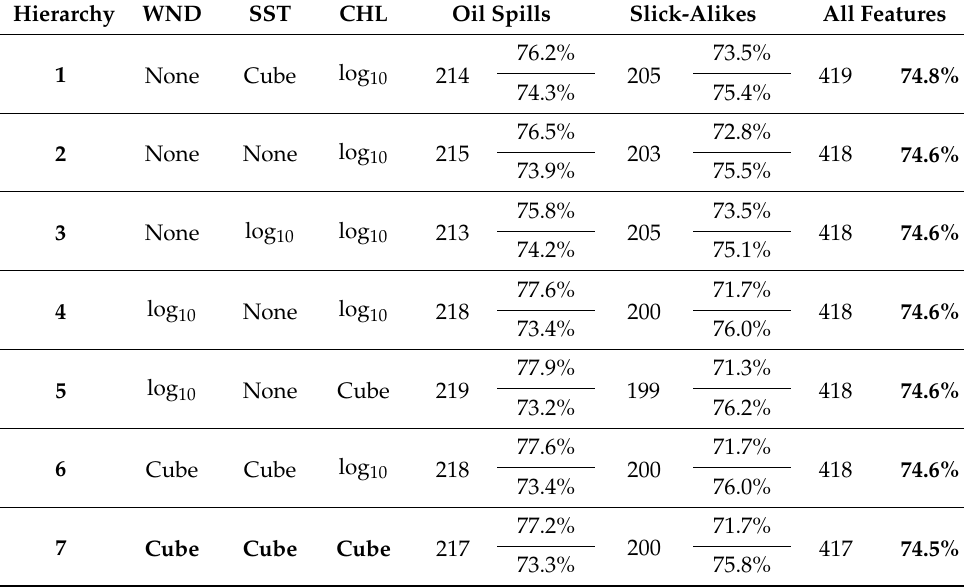
Table 6. Classification accuracy hierarchy of the 27 algorithms using three variables subjected to different data transformations in the same analysis—Meteorological-Oceanographic data (metoc: “Metoc Assemblage”—wind speed (WND), sea surface temperature (SST), and chlorophyll-a con- centration (CHL)). Bold font indicates baseline combinations with the same transformation. For the interpretation of thick table lines see Section 4.3.1. Detailed statistical information is found in Figure 4. See also Tables 1 and 7, and Section 4.3: Experiment 2